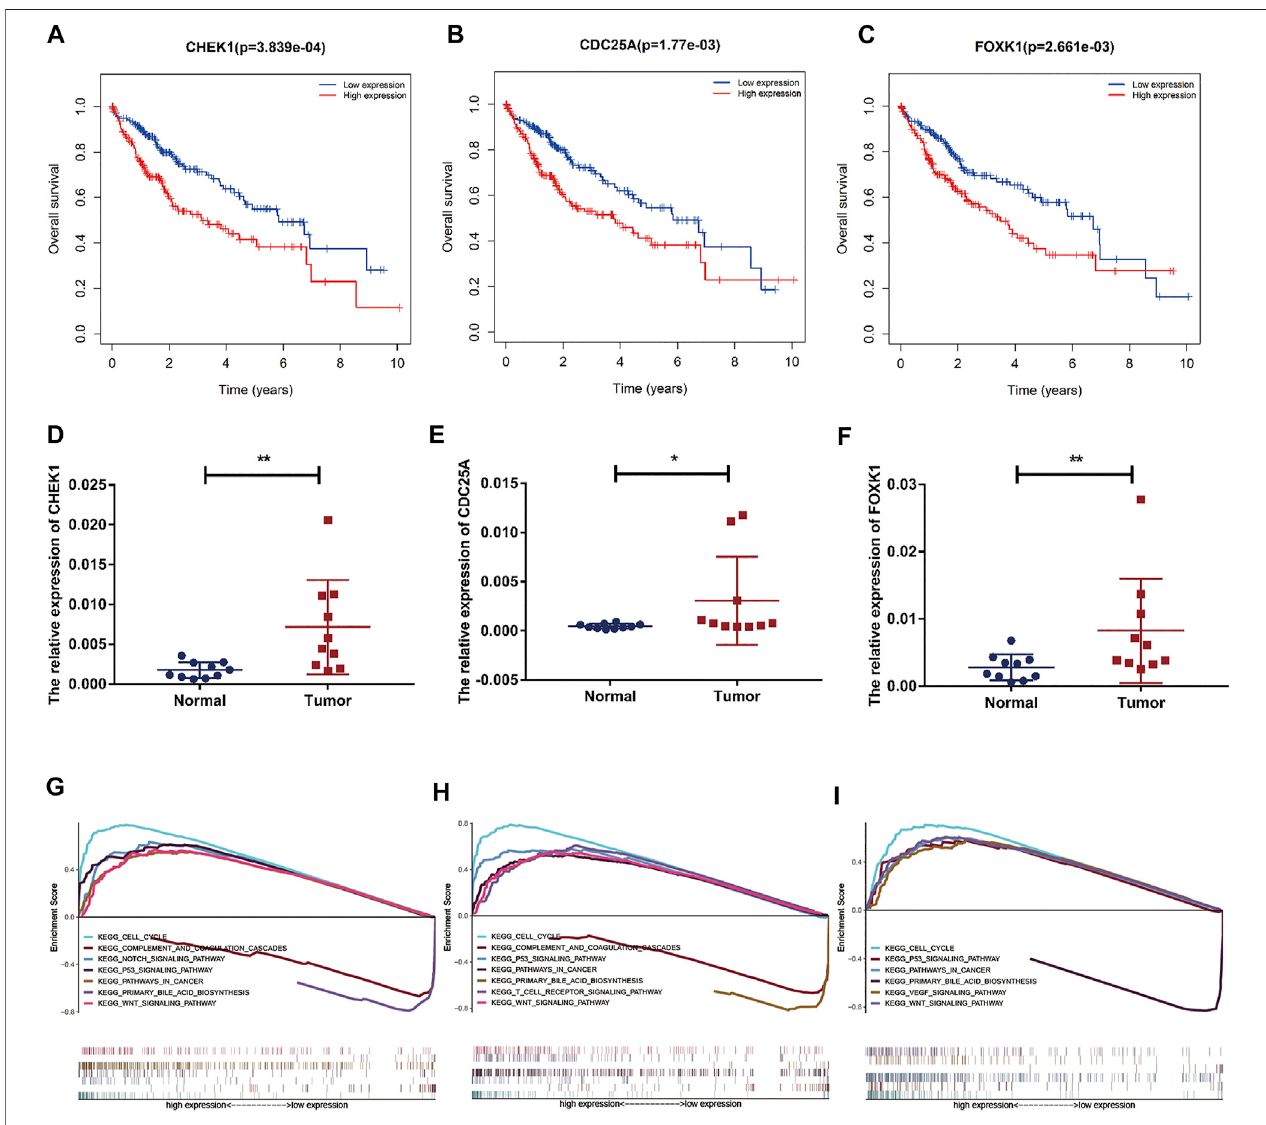
FIGURE 8 | Prognostic assessment and GSEA of target genes. (A – C) The prognostic value of CHEK1, CDC25A, FOXK1 in LIHC. (D – F) mRNA expression of CHEK1, CDC25A and FOXK1 in LIHC tissues and adjacent normal tissues ( n = 10) (G – I) GSEA of CHEK1, CDC25A and FOXK1 expressed in the ceRNA